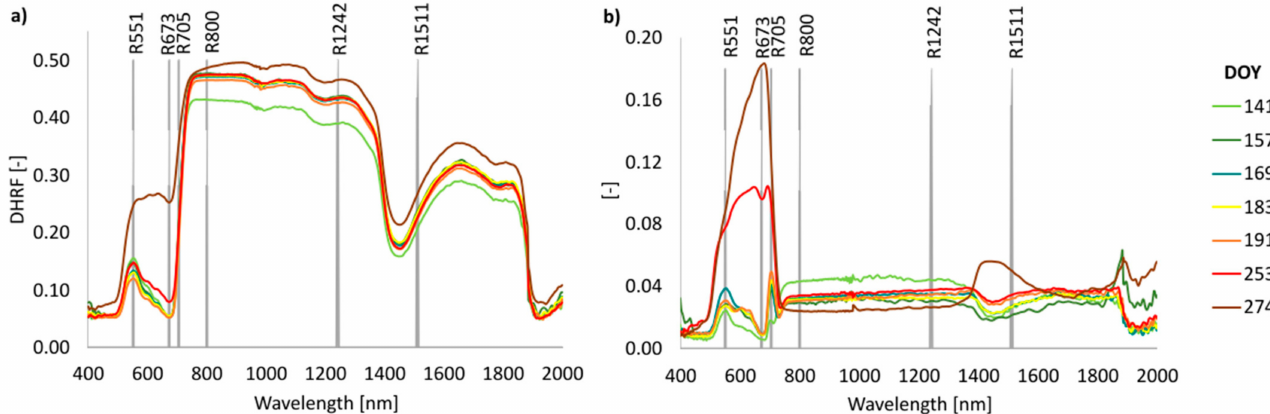
Figure 7. Mean DHRF—Directional Hemispherical Reflectance Factor and its variability (represented by standard deviation) for all leaf developmental stages pooled during the season: ( a ) Mean DHRF [–]; ( b ) standard deviation of DHRF; grey vertical lines correspond to reflectance of selected wavelengths representative for red, green, red-edge, NIR, and SWIR spectral regions that were evaluated for differences by ANOVA (see Supplementary Figures